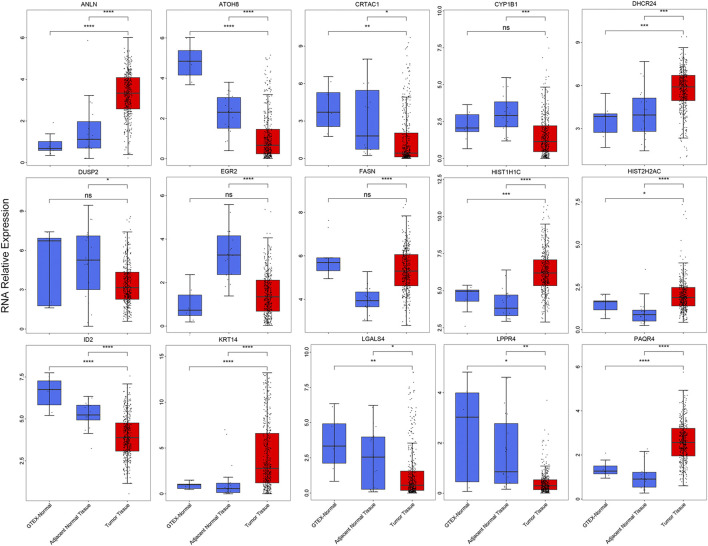
The boxplots show the expression of 15 prognosis-related genes in TCGAMIBC, adjacent non-carcinoma tissues, and GTEx normal tissues, t-test was used to calculate the significance level between two groups.